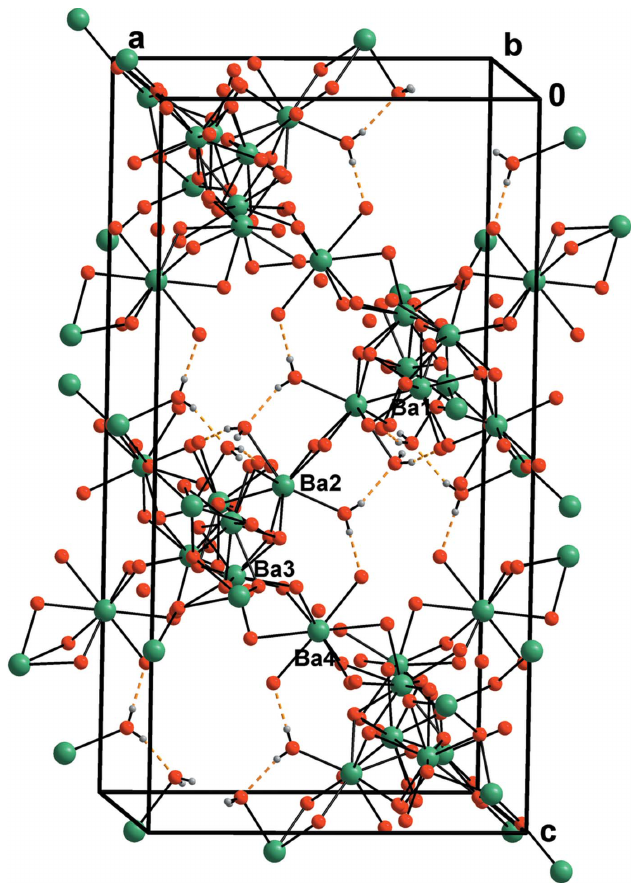
Figure 4 A view of the crystal structure excluding the propionate methylene and methyl groups as well as the disordered propionic acid molecule. Ba— O—Ba bonds and O—H (cid:2)(cid:2)(cid:2) O bonds [except for O16 (cid:2)(cid:2)(cid:2) O4 vii ( (cid:4) x + 1, (cid:4) y , (cid:4) z + 1) where the bridging hydrogen atom was not found] are displayed. For colour codes, see caption for Fig. 1.